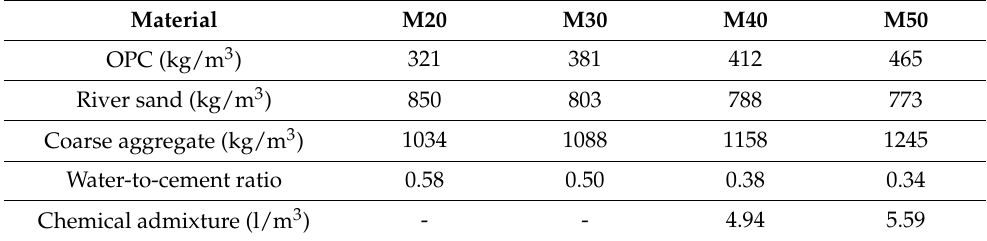
Figure 1. Images of ( a ) test specimens, ( b ) heating and water cooling, ( c ) heating–cooling cycle of concrete specimens, ( d ) cubes under elevated temperature, ( e ) cylinders under elevated temperature, ( f ) beams under elevated temperature. Table 1. Physical properties of materials. Table 2. Details of design concrete-mix